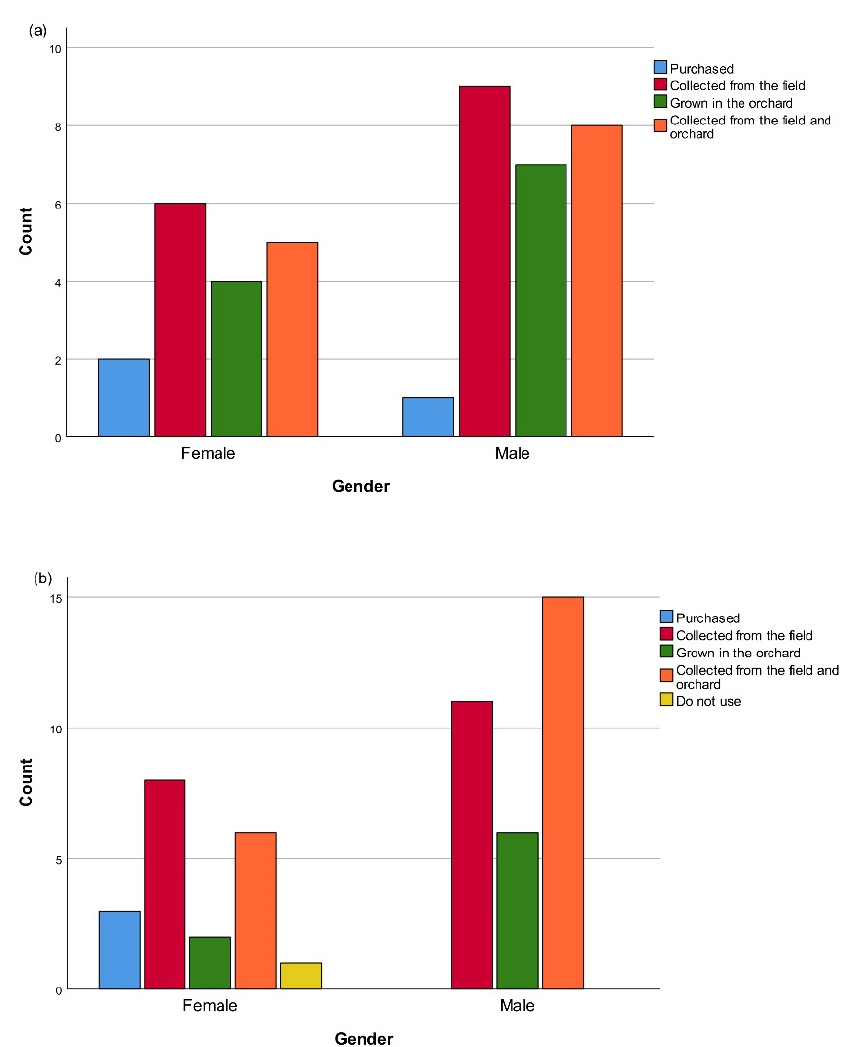
Figure 4. How the inhabitants of Quinua ( a ) and Acos Vinchos ( b ) obtain medicinal or aromatic plants according to gender.